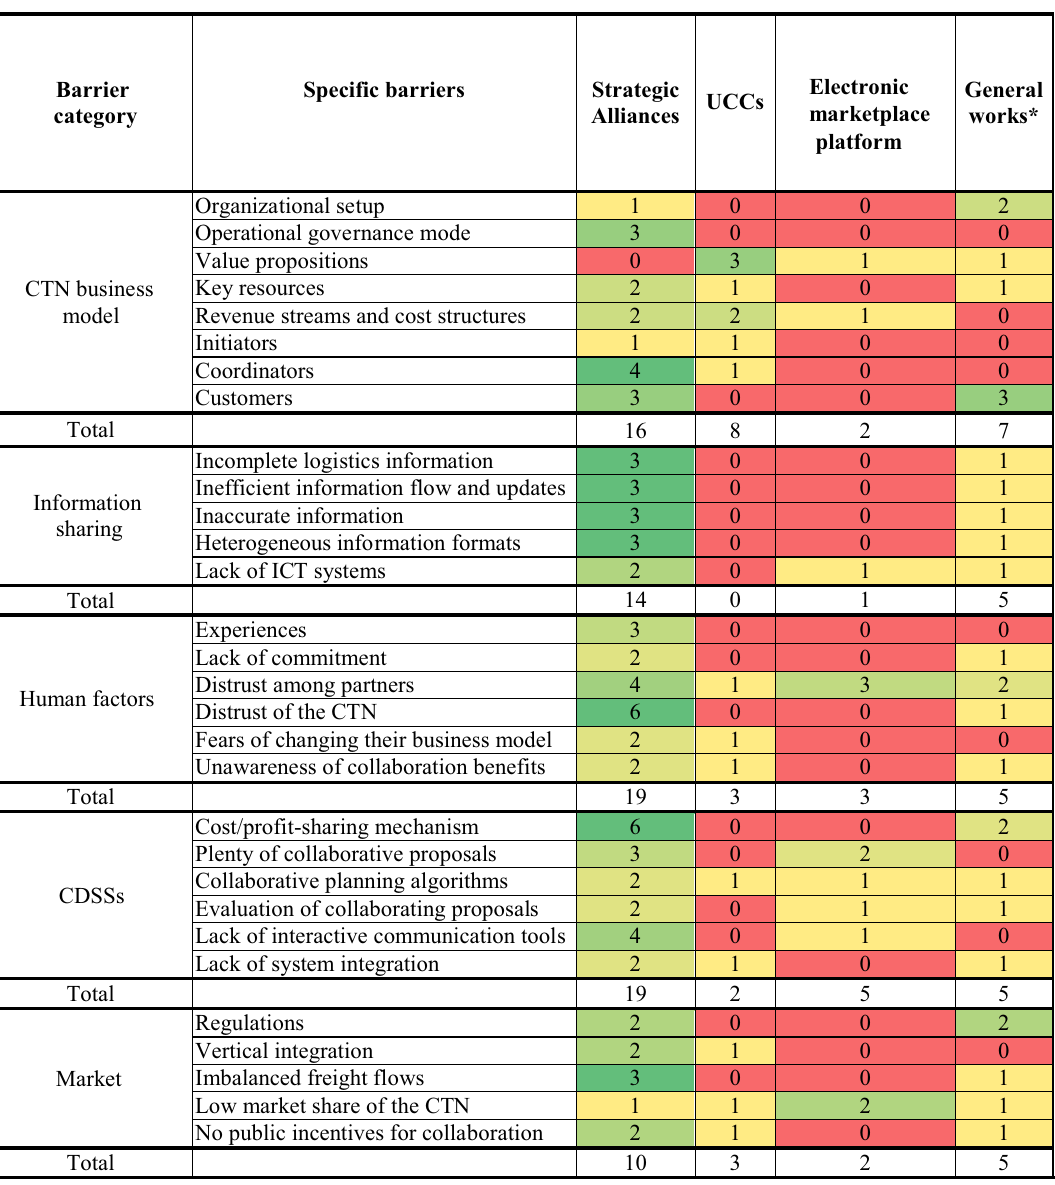
Table 2 Classification of identified barriers and the CTN solutions